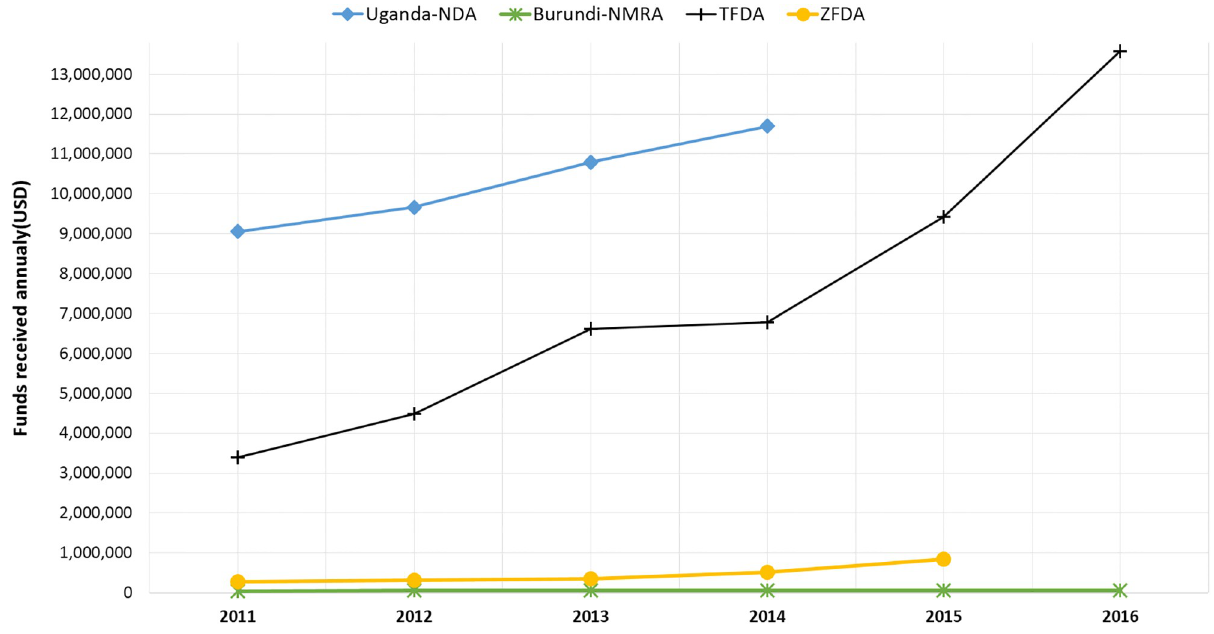
Fig 2. Trends in annual funding among national medicines regulatory authorities in the East African Community.